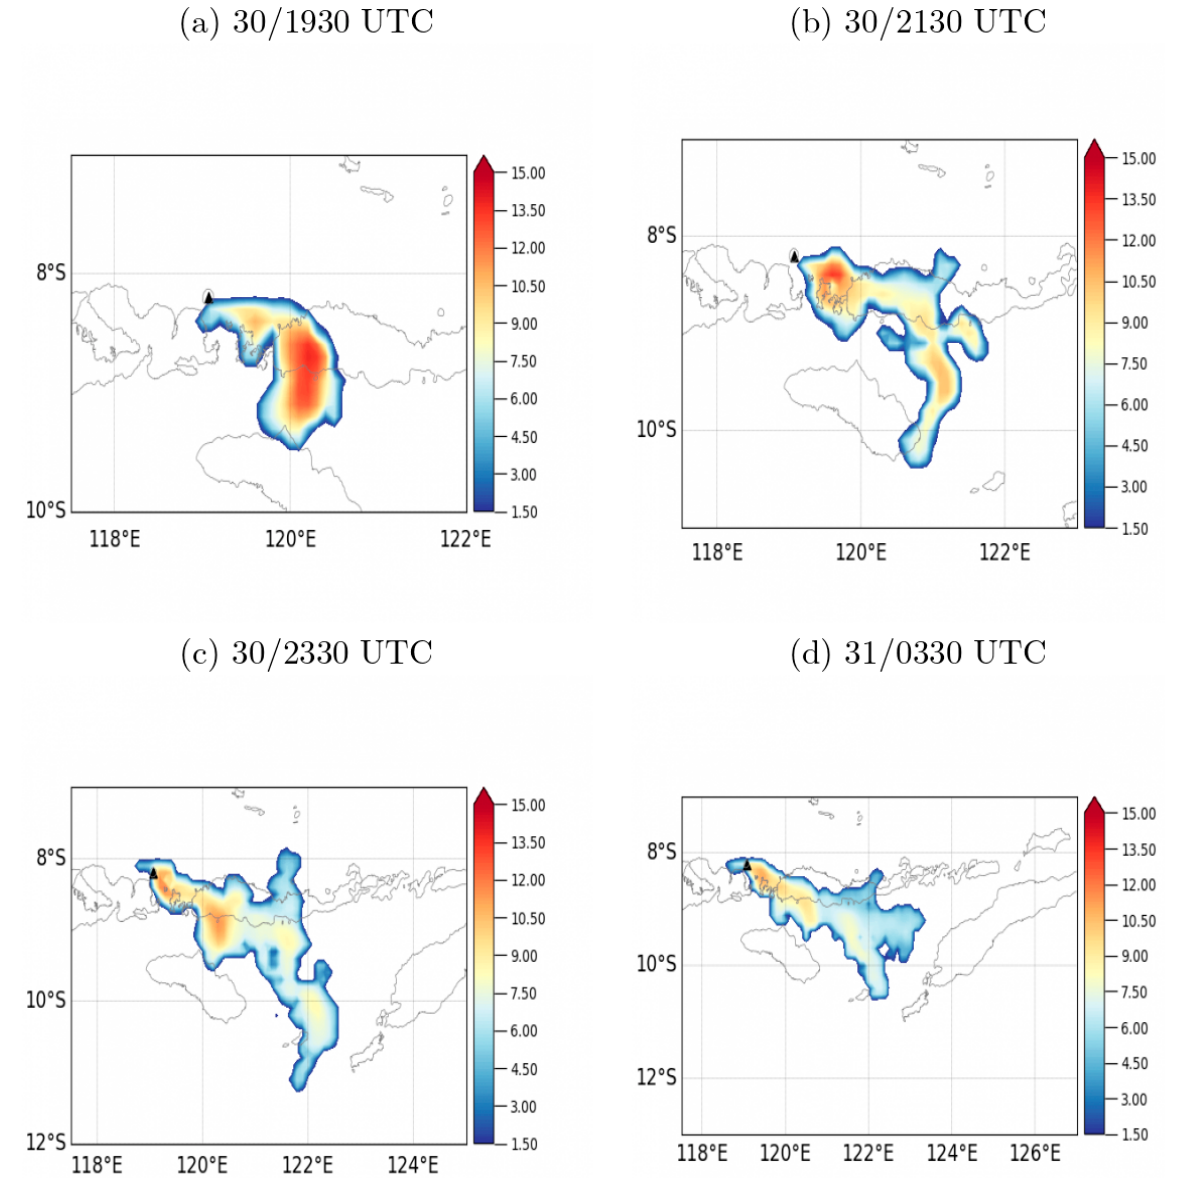
Figure 3. VOLCAT cloud top height retrievals (in km) corresponding to the 30 May Sangeang Api eruption at times indicated on the panels. The black triangle indicates the volcano location.